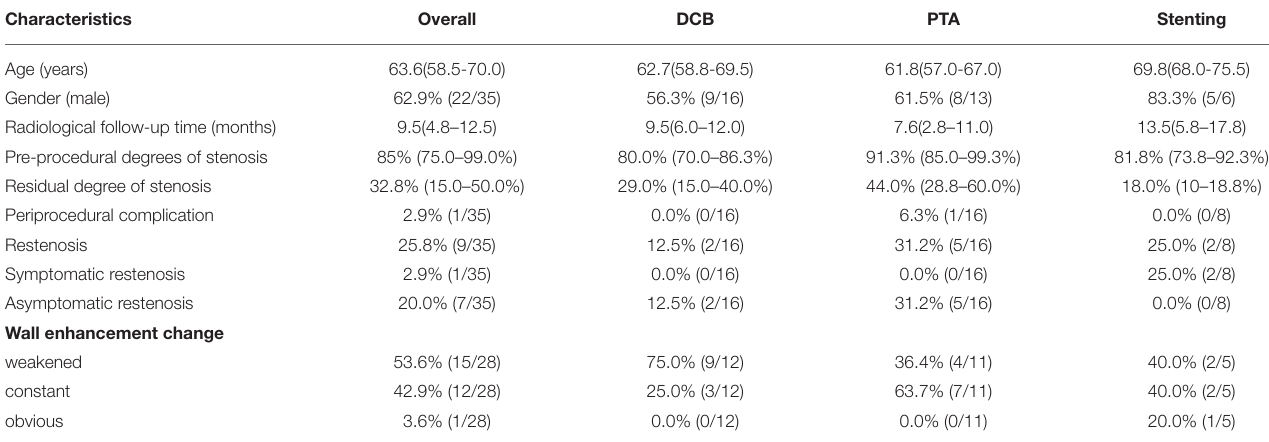
TABLE 1 | Characteristics of patients who underwent endovascular recanalization and received high-resolution magnetic resonance (HR-MR) follow-up.